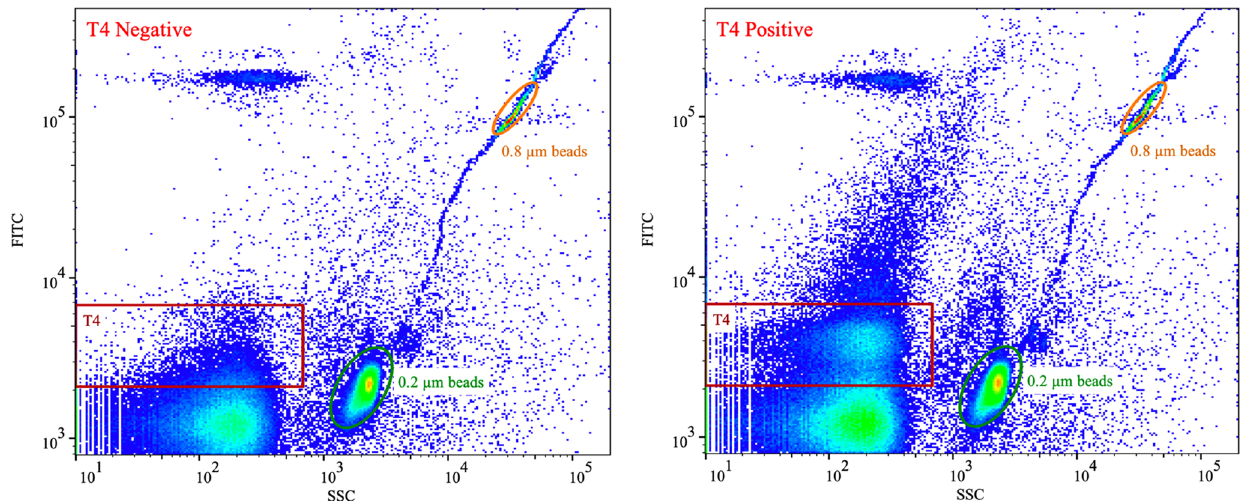
Fig. 7 Representative plots showing manual gating of data collected from environmental-spike experiments. Gates were the same as the gates used in the mixed-target experiments, albeit for only a subset of the mixed-target populations. T4 Negative shows results for the sample without the T4 spike, T4 Positive shows results for the spiked